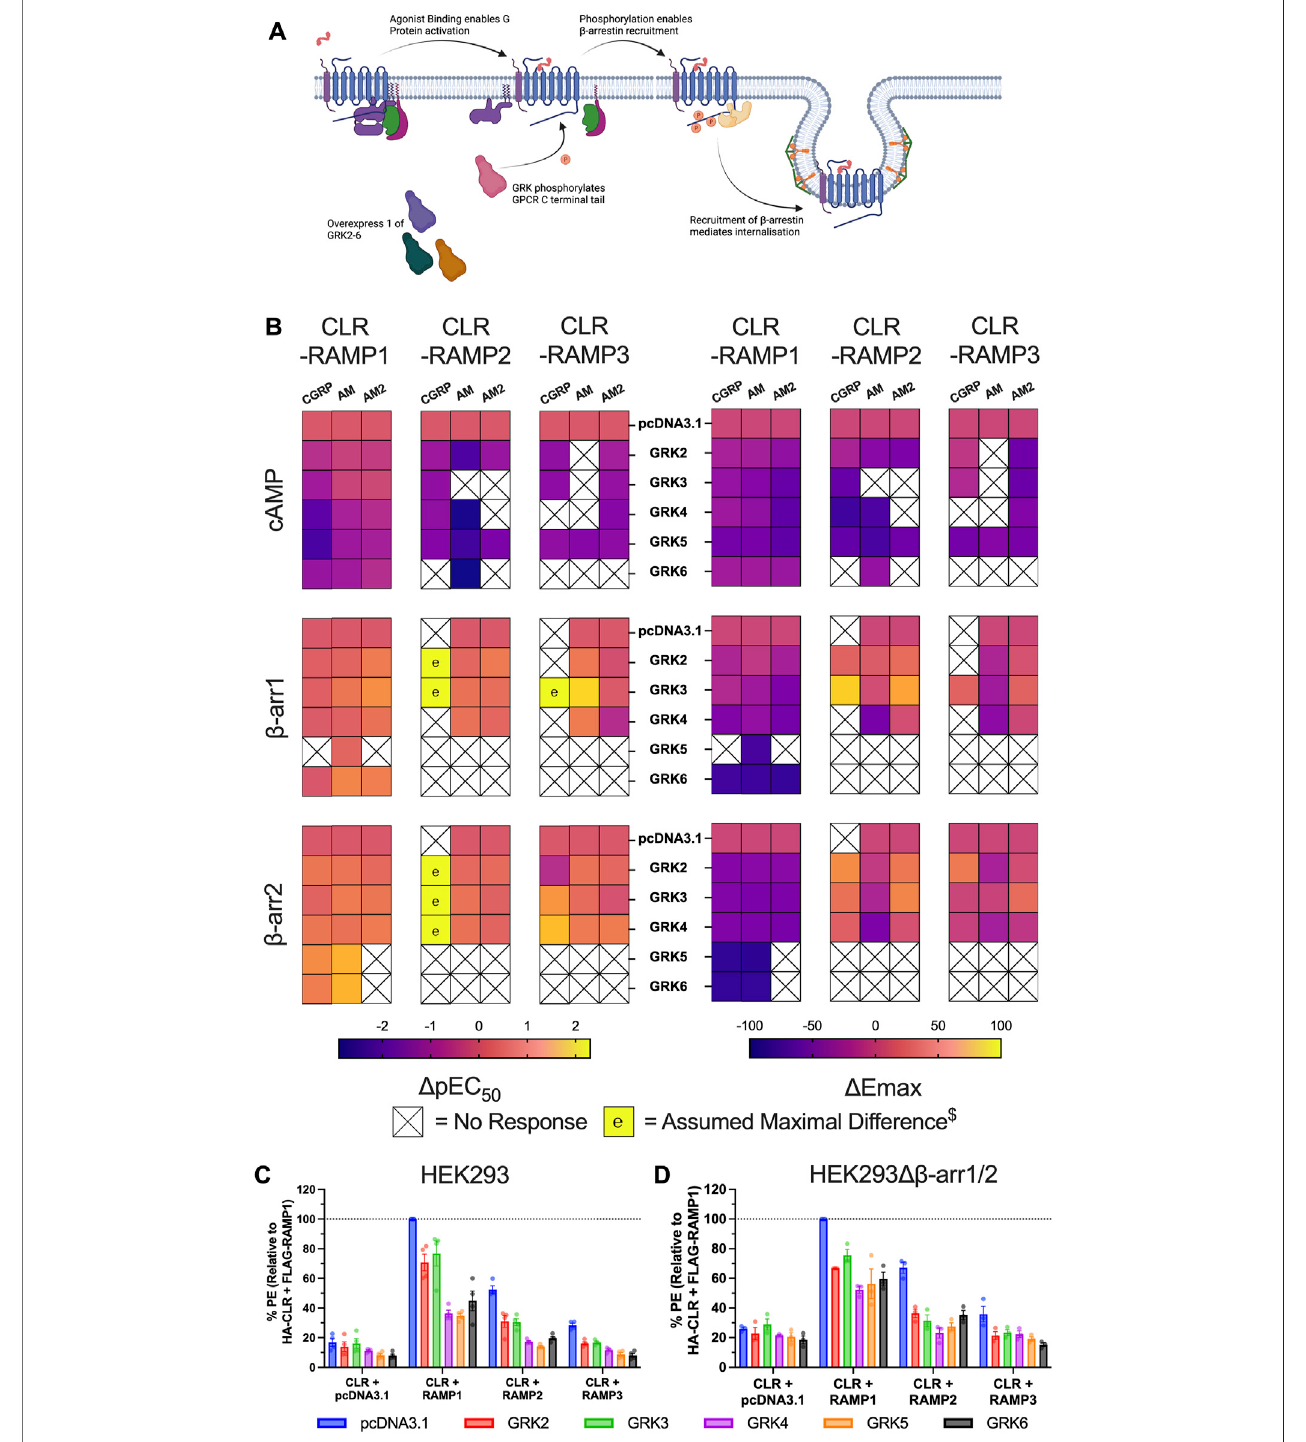
FIGURE5| GRKoverexpressionimpairsCLR-RAMPcomplexsignallingthroughconstitutivereceptorinternalisation. (A) Schematic(createdwithBioRender.com) showing the role of GRKs in mediating GPCR desensitisation and internalisation, and highlighting how we manipulated this system for the experiment. (B) Heat maps illustratingtheeffectsofoverexpressionofeachGRKonthepotency(left)andEmax(right)oncAMPaccumulation,and β -arrestin1/2recruitmentatthethreeCLR-RAMP complexeswhenstimulatedwithCGRP,AMandAM2.$MaximalchangeinpEC 50 wasassumedwherenoresponsewasobservedintheabsenceofGRK. (C – D) Cell surface expression of HA-CLR, measured using a phycoerythrin (PE)-conjugated anti-HA antibody, following overexpression of GRKs prior to addition of agonist in HEK293 cells (C) and HEK293 Δβ -arrestin1/2 cells (D) . All data are mean ± SEM of n repeats where n ranges between 3 and 4 experiments.